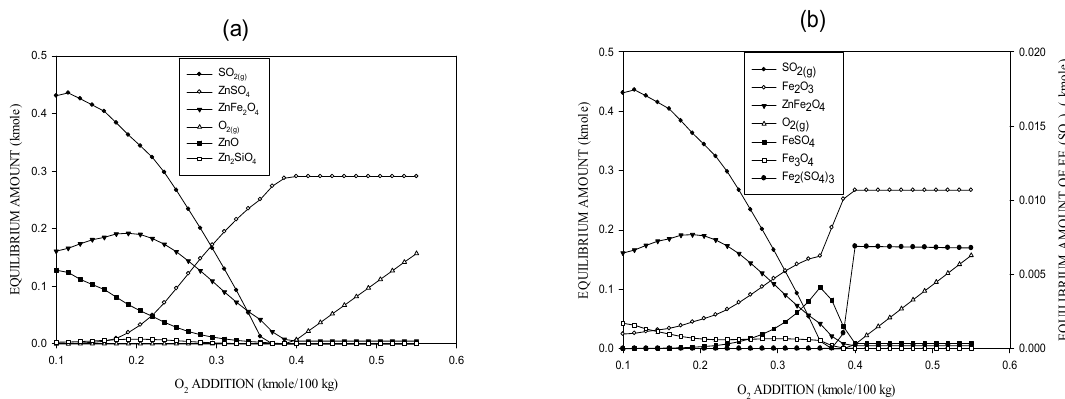
Figure 5. ( a ) Equilibrium amounts of both the zinc-containing and the gaseous species as a function of the oxygen addition for a sulphur dioxide addition of 0.68 kmole/100 kg of dust. ( b ) Equilibrium amounts of both the iron-containing and the gaseous species as a function of the oxygen addition for a sulphur dioxide addition of 0.68 kmole/100 kg of dust.